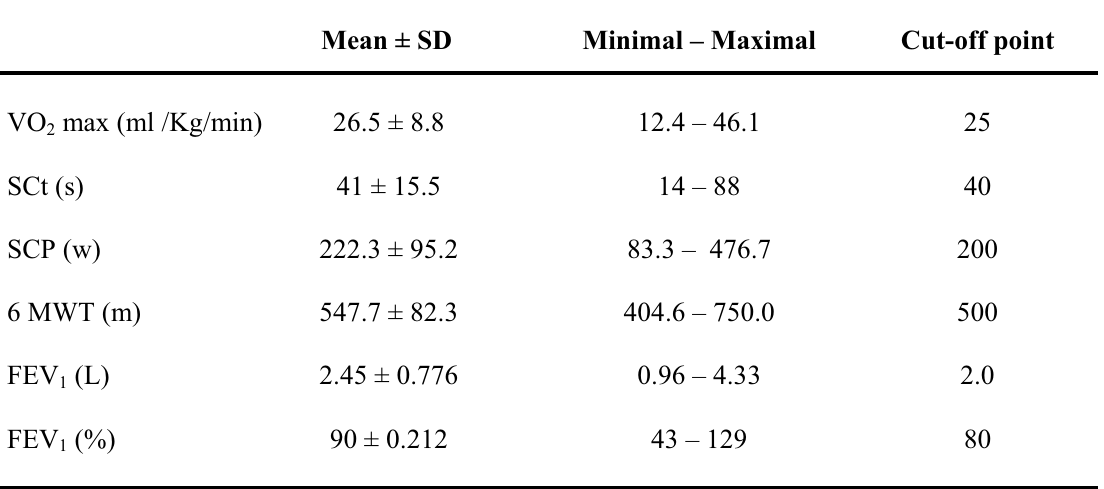
TABLE 2 - Linear correlation between VO